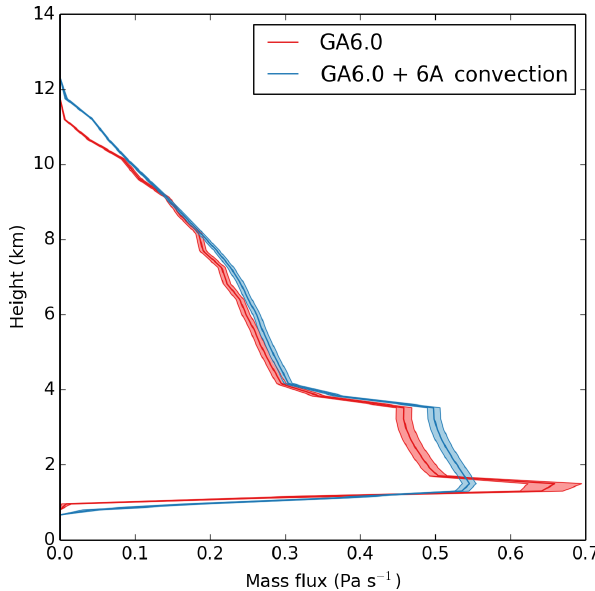
Figure 4. Profiles of mean convective mass flux from a pair of 100- member SCM ensembles using the GA6 configuration and the 6A convection scheme. The initial profiles and forcings are for an ide- alised diurnal cycle over tropical land (described in detail as exper- iment “r76” in Table 1 of Stirling and Stratton, 2012). The profiles are for 4h means centred on local noon; the thick lines show the time-averaged ensemble mean and the shading shows ± 2 times the standard error in the ensemble